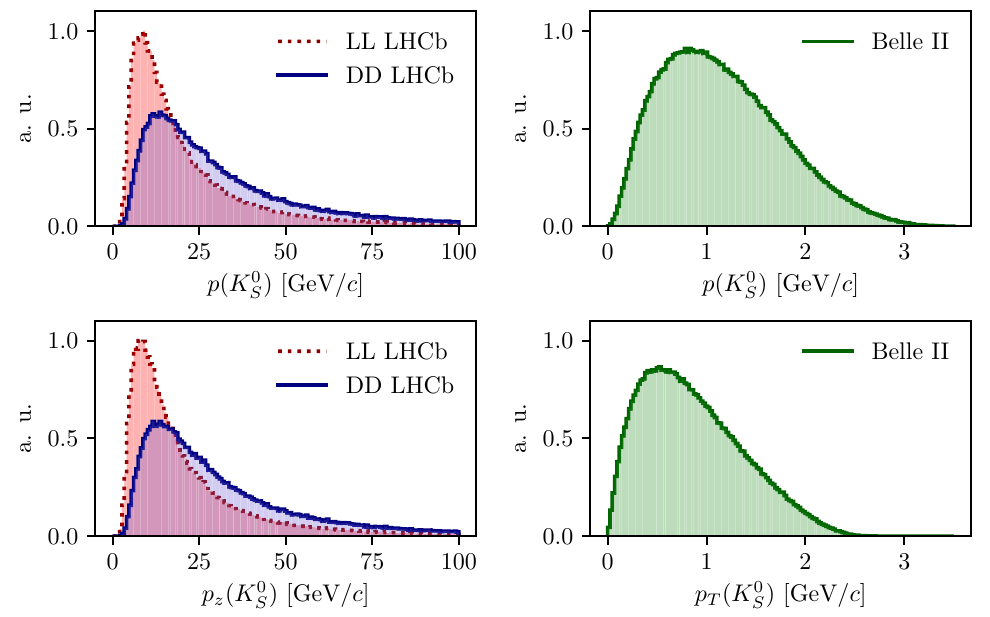
Figure 3 . Momentum distributions for the LHCb (red dotted line) LL and (blue) DD categories, as well as (green) Belle II, obtained using RapidSim